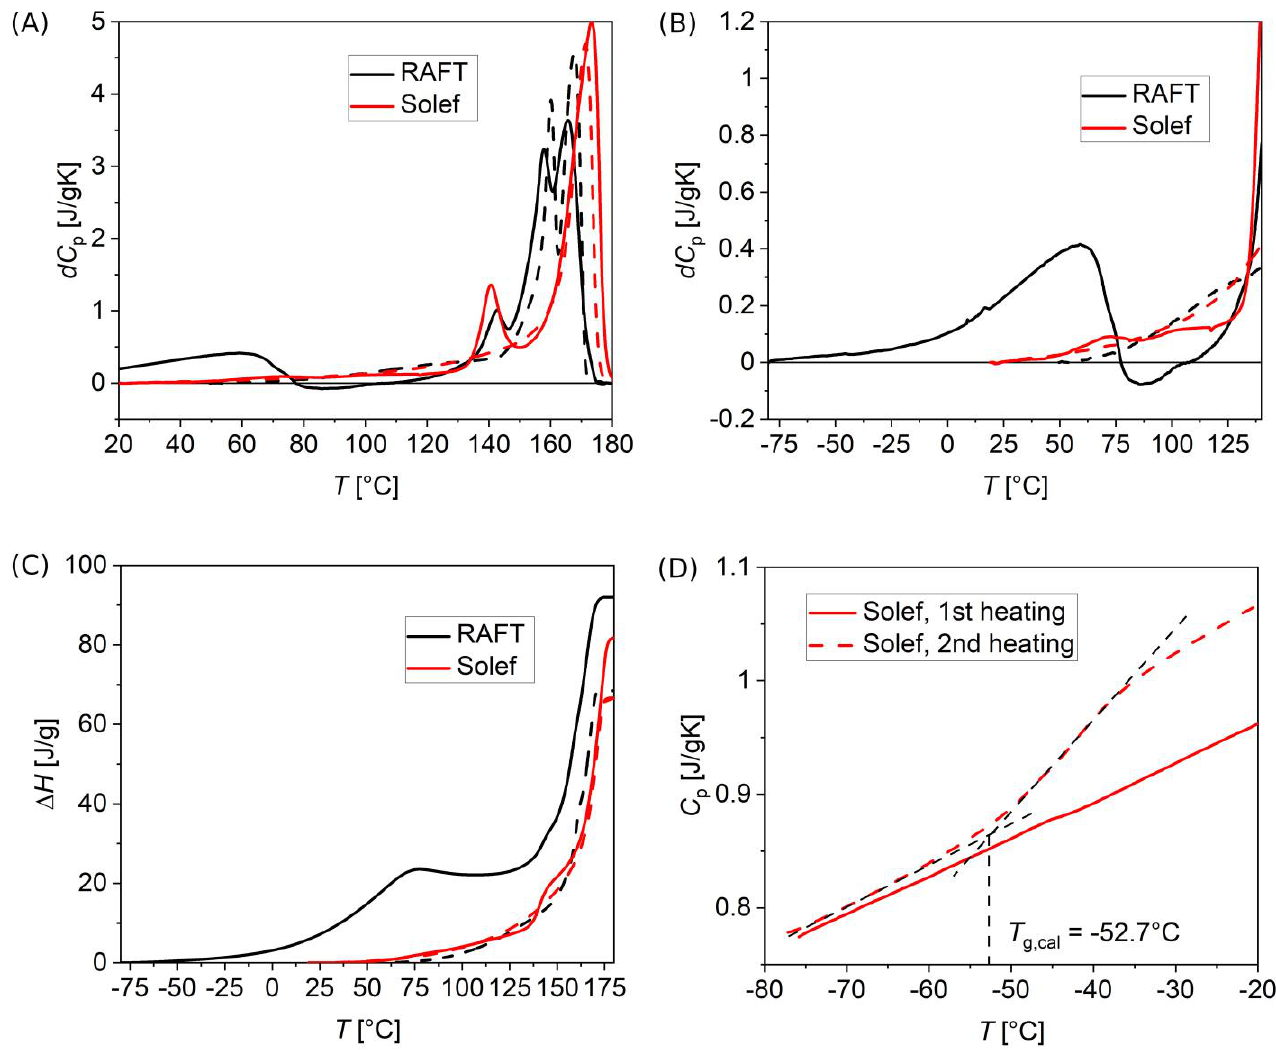
Figure 6. DSC thermograms of PVDF samples obtained by RAFT polymerization (RAFT, black curves) and commercial high molar mass PVDF (Solef, red curves), by ramping temperature starting from − 80 ◦ C to 180 ◦ C at a rate of 10 ◦ C/min, for the as-produced samples (solid curves), and after successive cooling (dashed curves). ( A ) Specific heat overview, after a baseline subtraction (indicated as dC p ), showing all melting processes. ( B ) Specific heat detail in a temperature range comparable to that of BDS isochronal scans of Figure 5. ( C ) Specific enthalpy, in the full temperature range. The measurements on nanocomposites (Figure S1 of the Supplementary Materials) showed no qualitative difference with respect to the neat RAFT polymer. ( D ) Determination of the calorimetric glass transition temperature T g,cal of Solef PVDF, from the change in specific heat C p , better evincible from the 2nd heating ramp, after cooling at the rate of 20 ◦ Table 3. Logarithmic relaxation frequency at infinite temperature (log f ) and activation energy ( E a ) ob- tained by Arrhenius best fitting of the three observed relaxation processes (as from Figure 4) for RAFT PVDF, PVDF- g -BT nanocomposites, residual ungrafted PVDF, and commercially available PVDF (Solef).